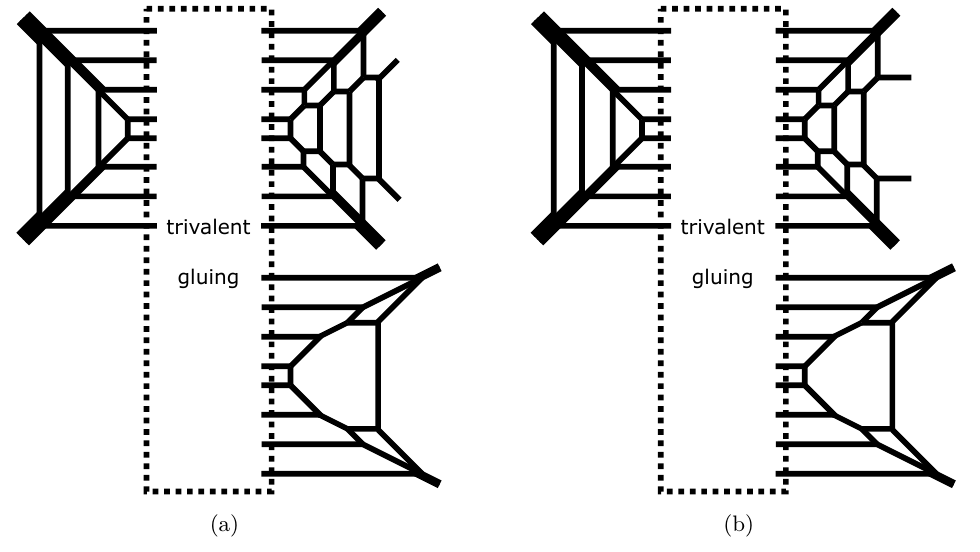
Figure 45. (a). The web diagram for the theory given by e (1) diagram for 5d E 7 gauge theory with 3 flavors but one mass parameter is turned off.